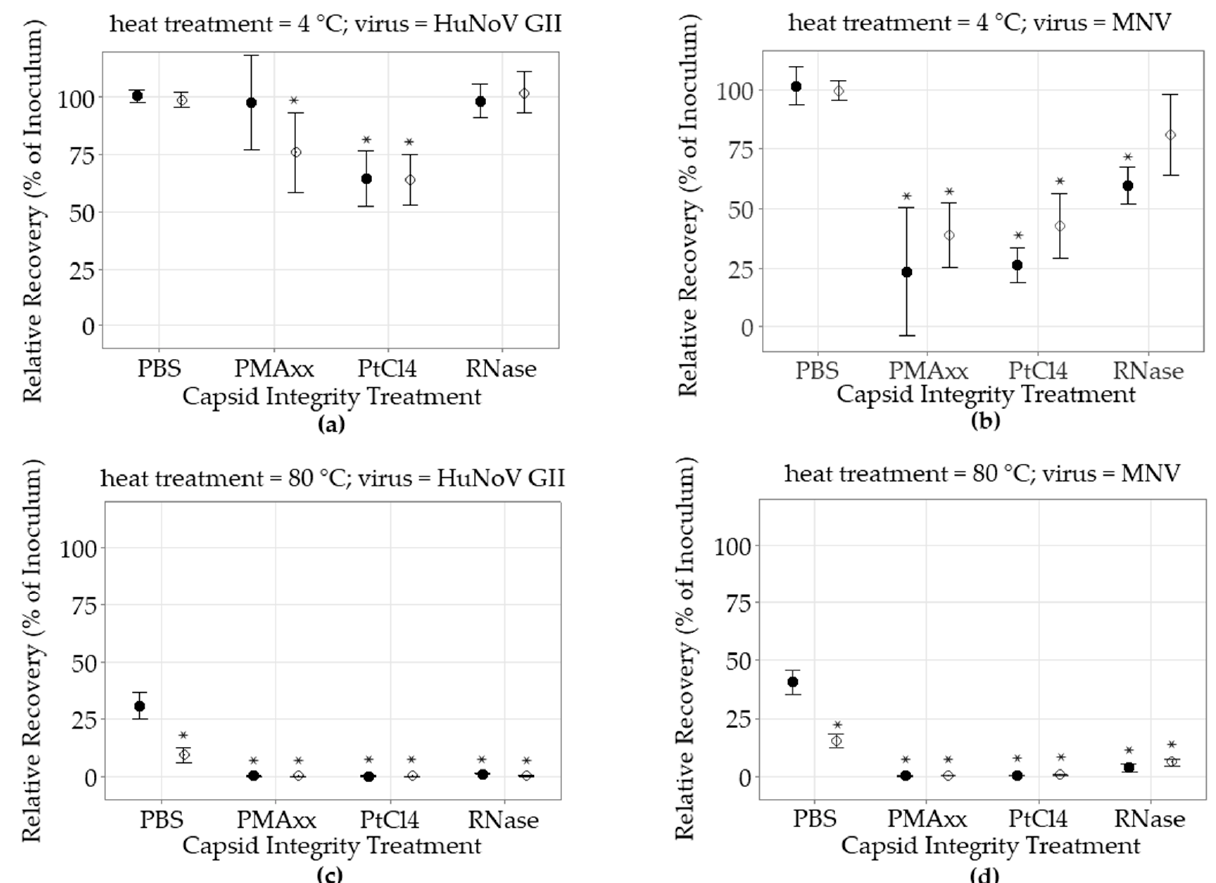
Figure 1. Impact of capsid integrity treatment on heat-treated norovirus recovery without food matrices. Viruses were heat-treated for 5 min or left untreated; ( a ) non heat treatment (4 °C) HuNoV GII; ( b ) non heat treatment (4 °C) MNV; ( c ) heat treatment (80 °C) HuNoV GII; ( d ) heat treatment (80 °C) MNV. Following heat treatment, the viruses were treated with either PBS, PMAxx, PtCl 4 , or RNase, and then the RNA was extracted and detected. Relative recovery results are expressed as percentage of the spiked inoculum as estimated by short RT-qPCR ( ● ) or long RT-qPCR ( ○ ) (mean ± 95% CI). The Dunnett’s multiple comparison test was used to identify significant differences (*) compared to the short RT-qPCR recovery of the virus without capsid treatment (PBS) ( p < 0.05).